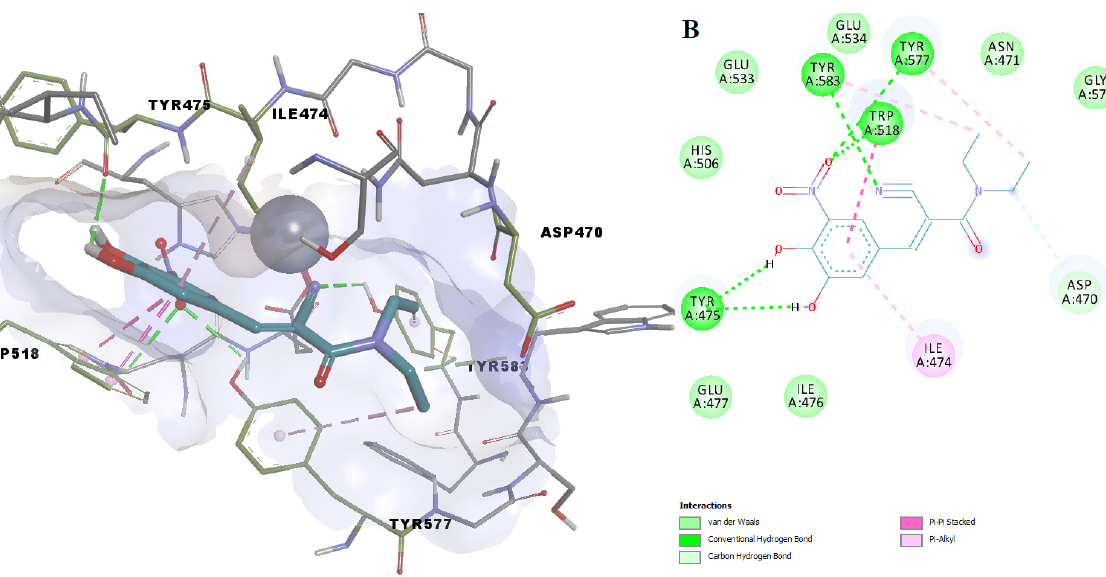
Figure 8. ( A ) 3D binding pose of entacapone into ColA active site; ( B ) 2D molecular interactions diagram for entacapone-ColA complex.